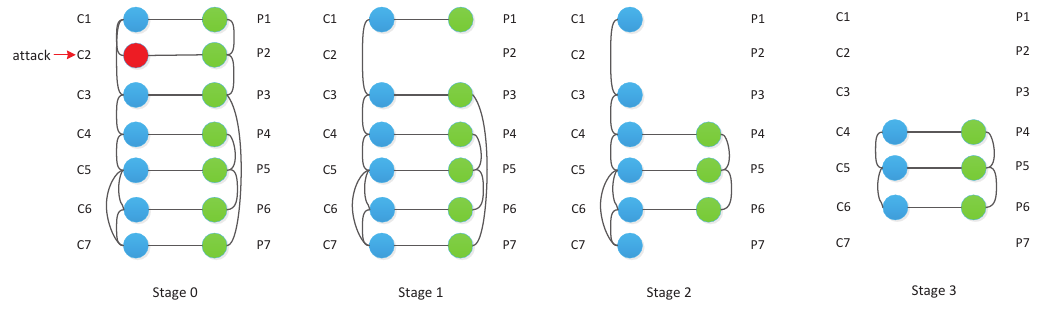
Figure 1. A specific example of the Cyber-Physical network failure